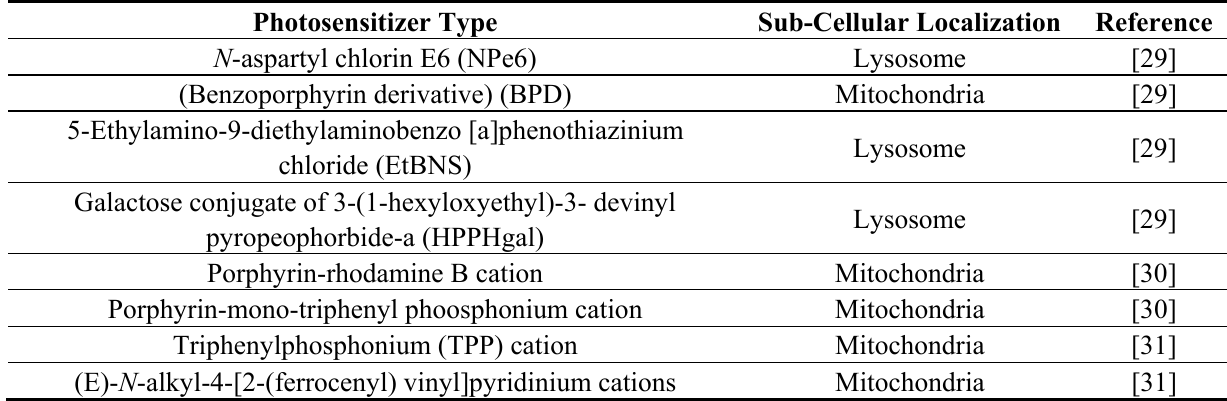
Table 1. Examples of PSs targeting lysosome and